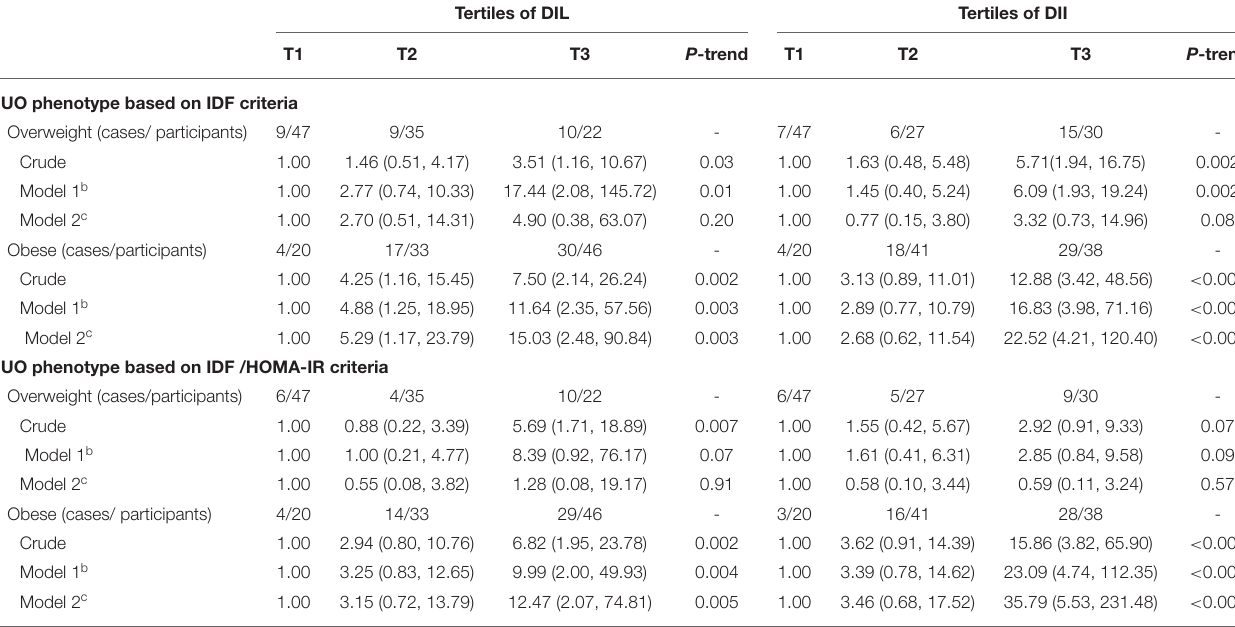
TABLE 4 | Multivariate adjusted odds ratio (OR) and 95% CI for MUO across tertiles of energy-adjusted DIL and DII, stratified by BMI categories a . Tertiles of DIL Tertiles of DII T1 T2 T3 P -trend T1 T2 T3 P -trend